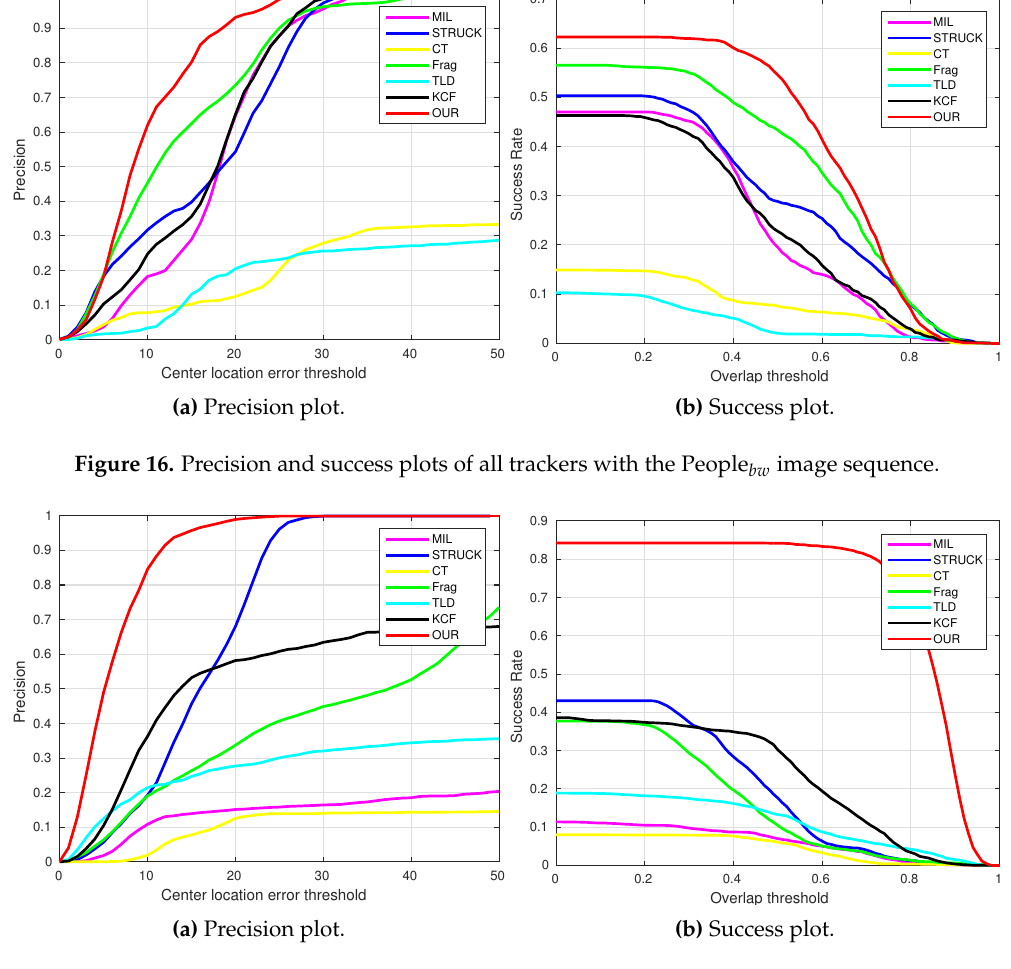
Figure 17. Precision and success plots of all trackers with the People fw image